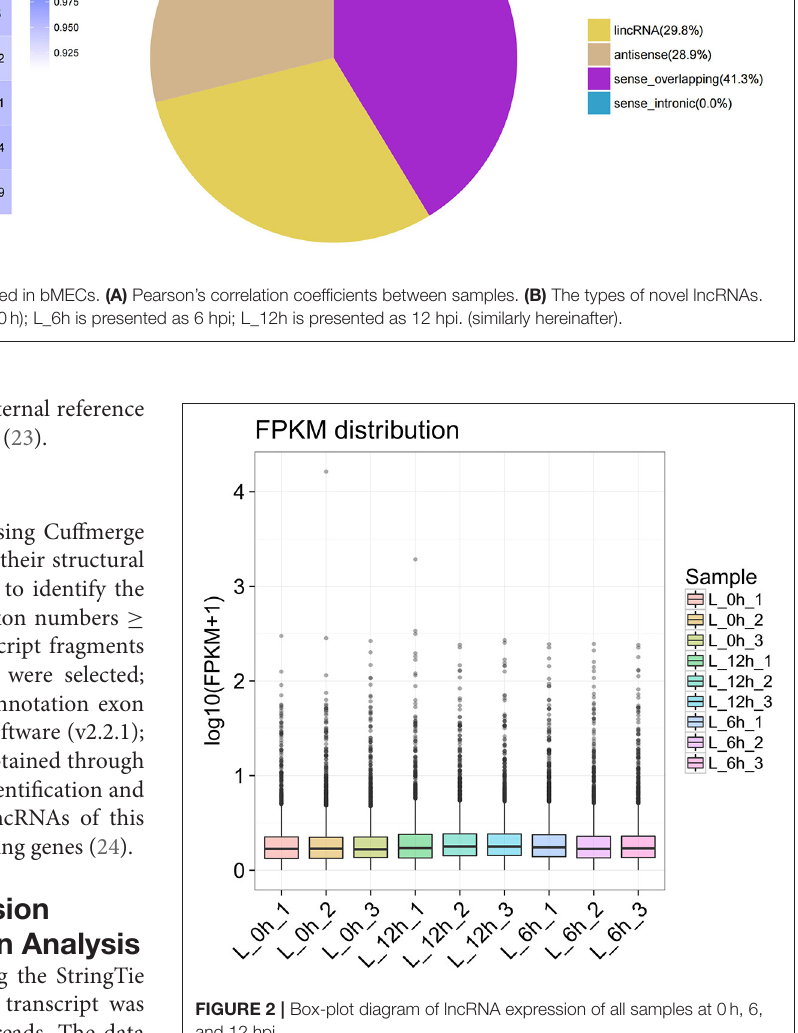
FIGURE 2 | Box-plot diagram of lncRNA expression of all samples at 0h, 6, and 12